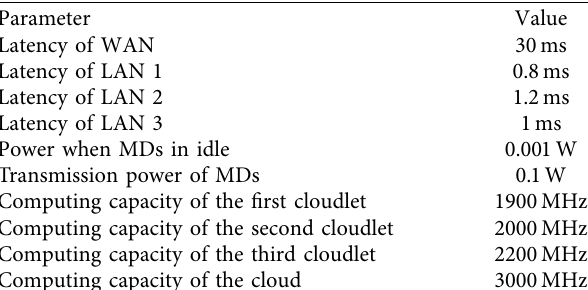
Table 2: Parameter